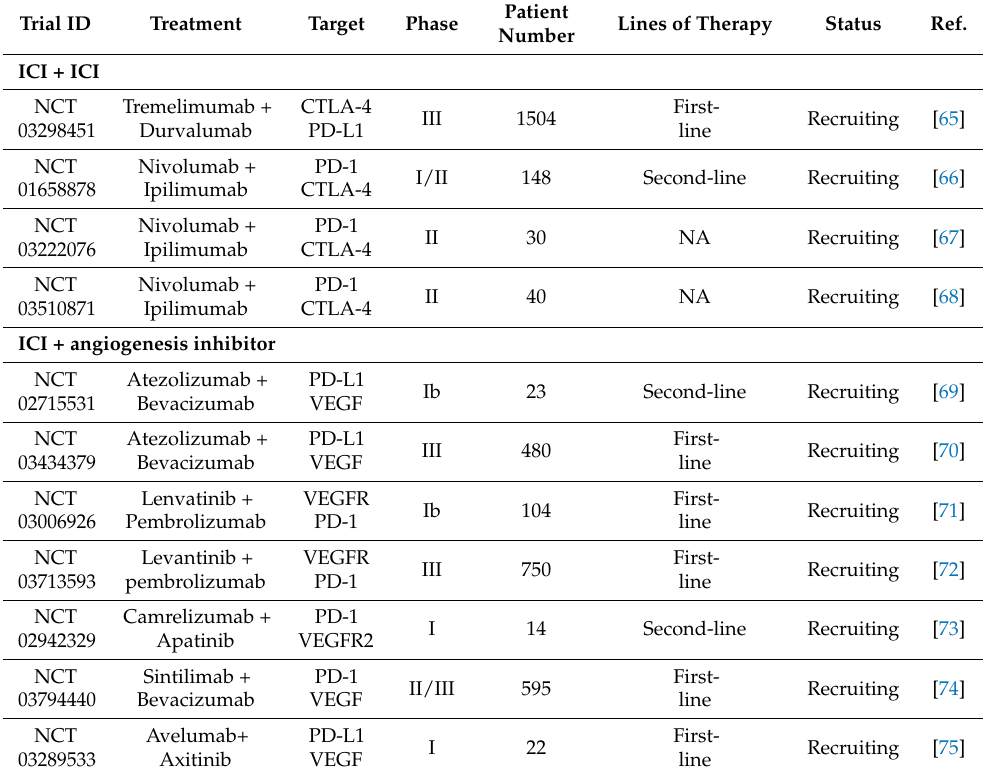
Table 2. Clinical trials investigating immune checkpoint inhibitor combination therapy in hepatocel- lular